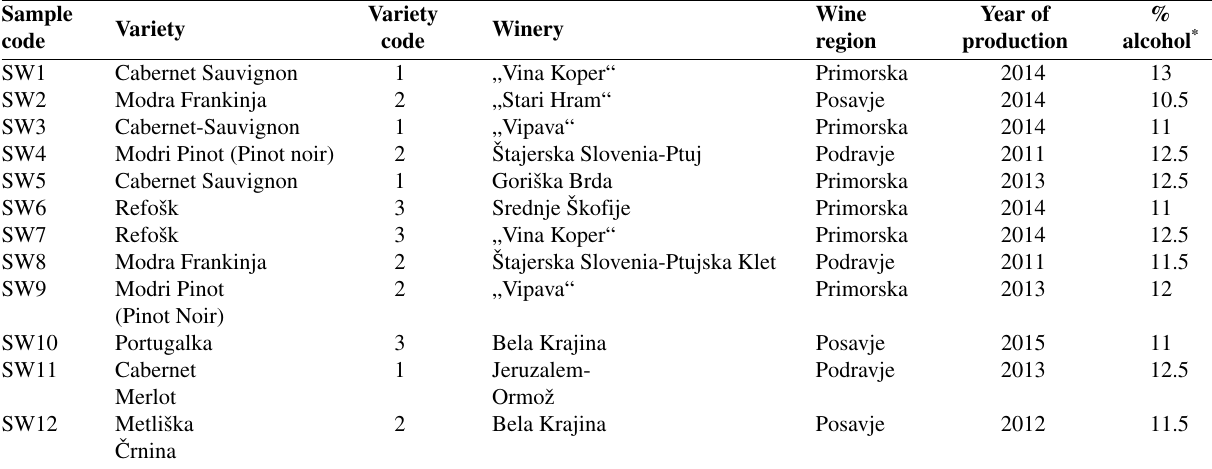
Table 1. Characteristics of the analyzed wine samples.